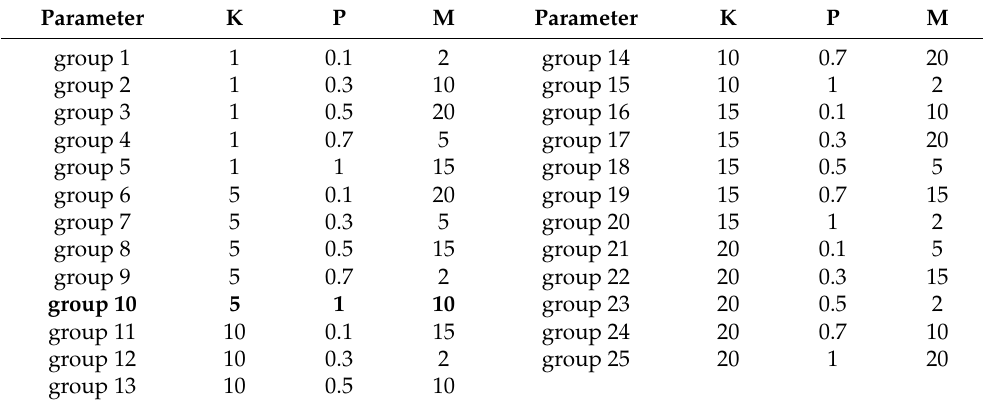
Table 2. Orthogonal experimental